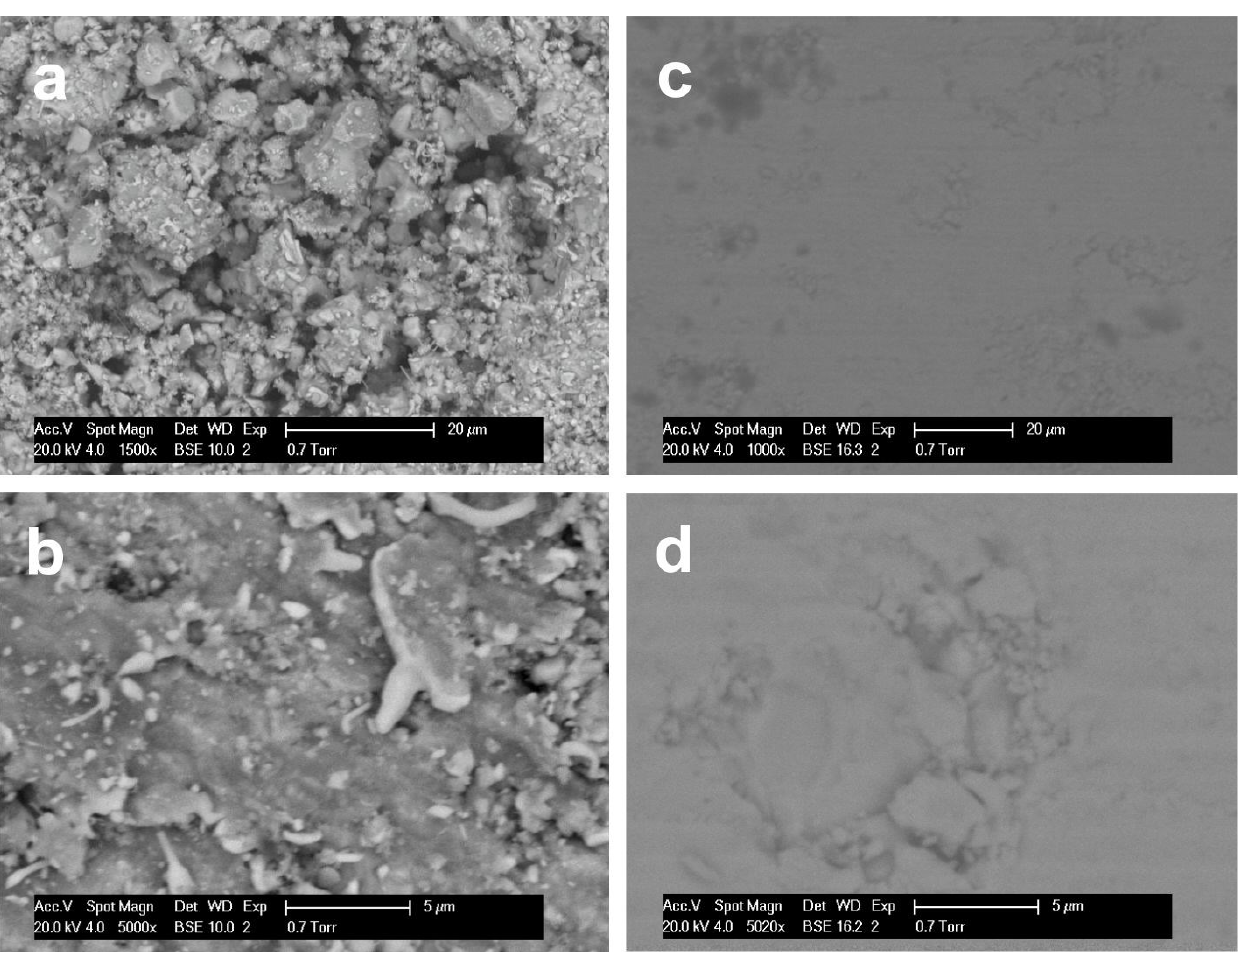
Figure 2. SEM images of Ti 0.5 Zr 0.5 NiSn(1) pre-SPS ( a , b ) and post SPS ( c , d